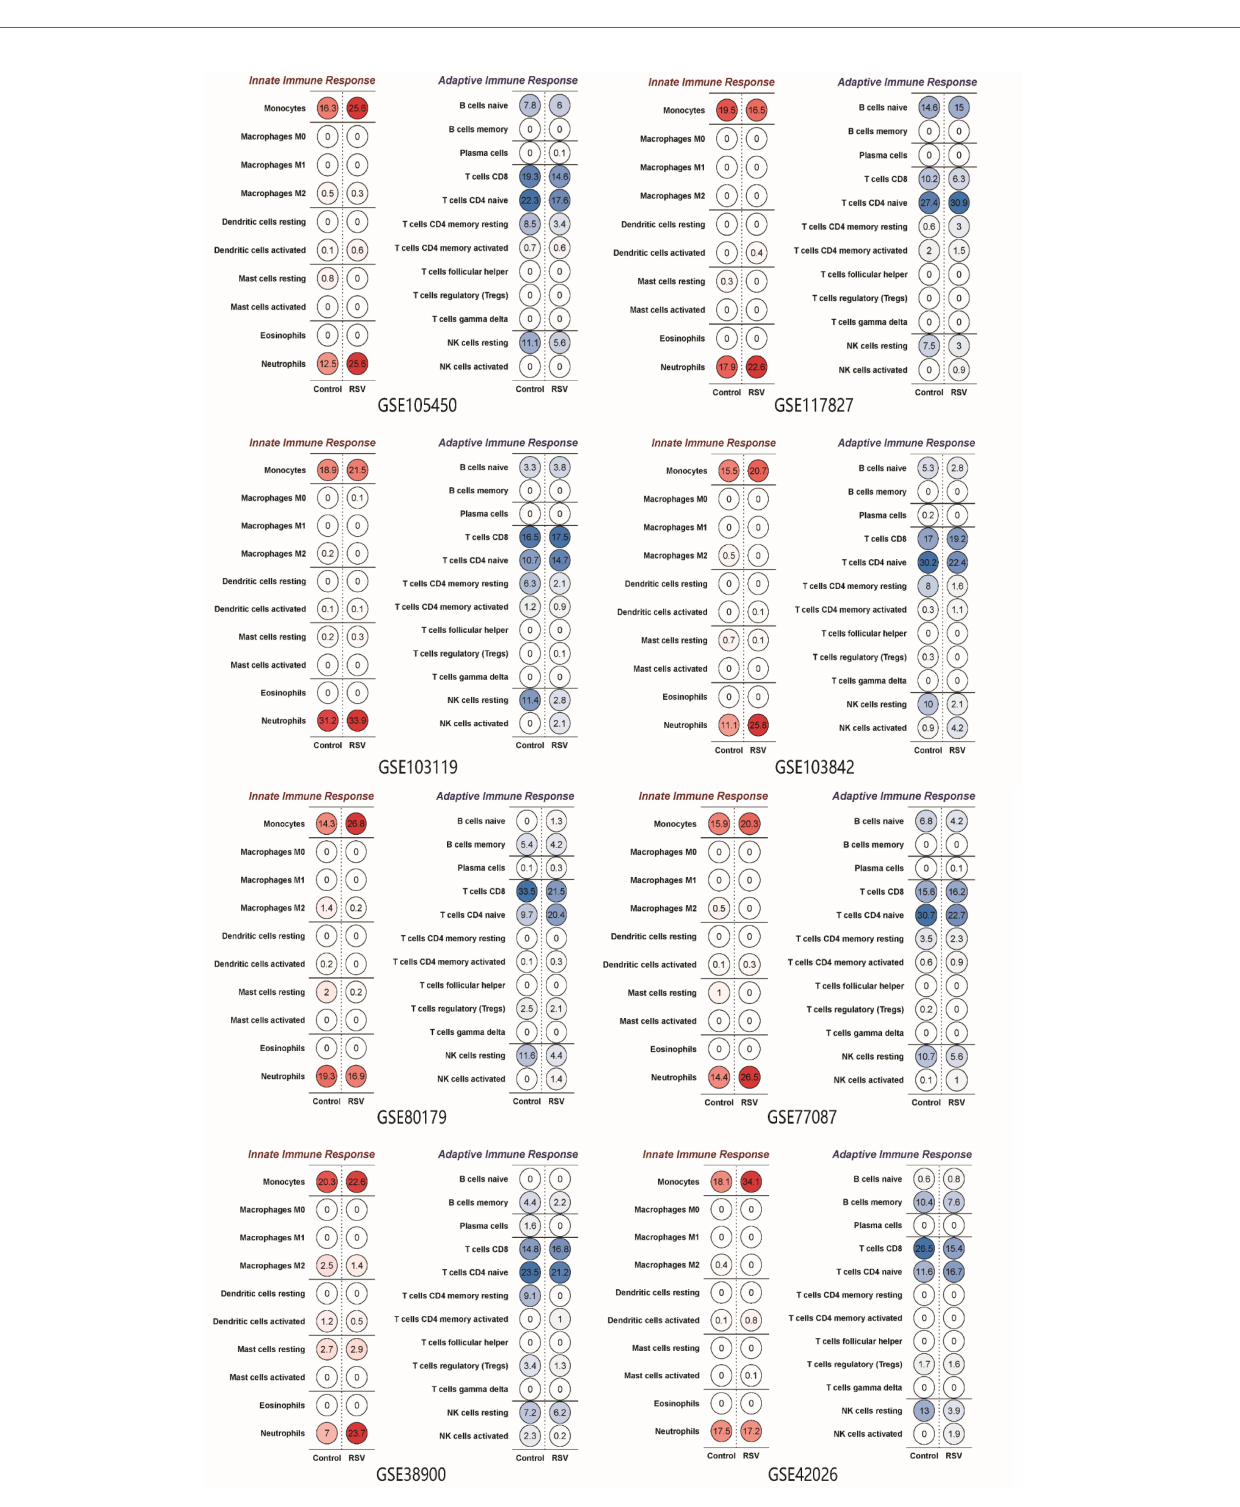
Frontiers in Cellular and Infection Microbiology |